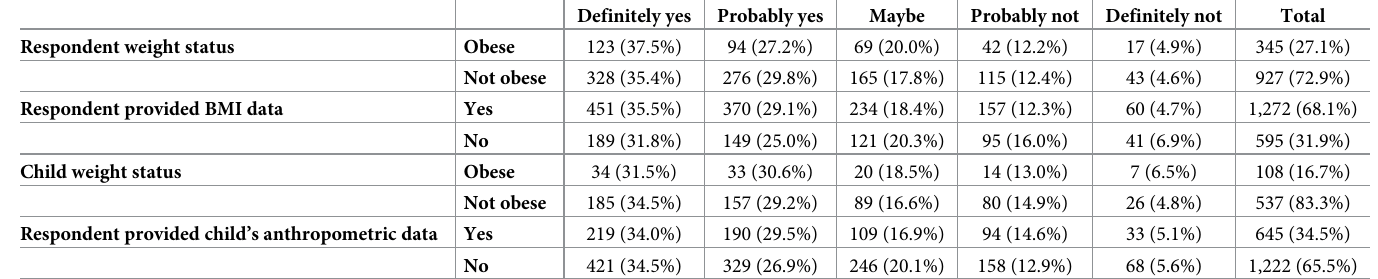
Table 3. Answers to the question ‘Would you like to know this information?’ according to respondent weight status (n = 1,272), provision of BMI data (n = 1,867), their child’s weight status (n = 645), and provision of anthropometric data on their child (n = 1,867).